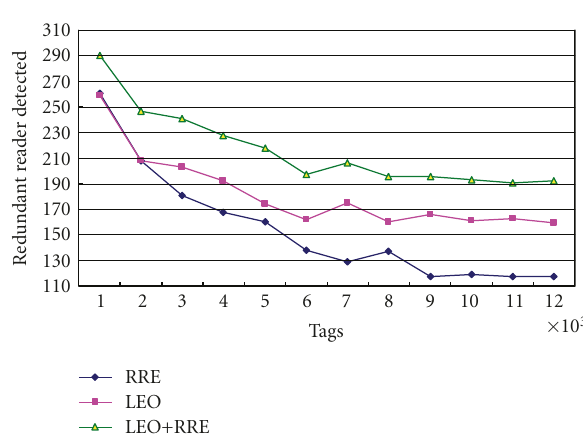
Figure 8: Comparison of redundant reader detected with network area 10000 × 10000, reader radius = 500, and number of reader =